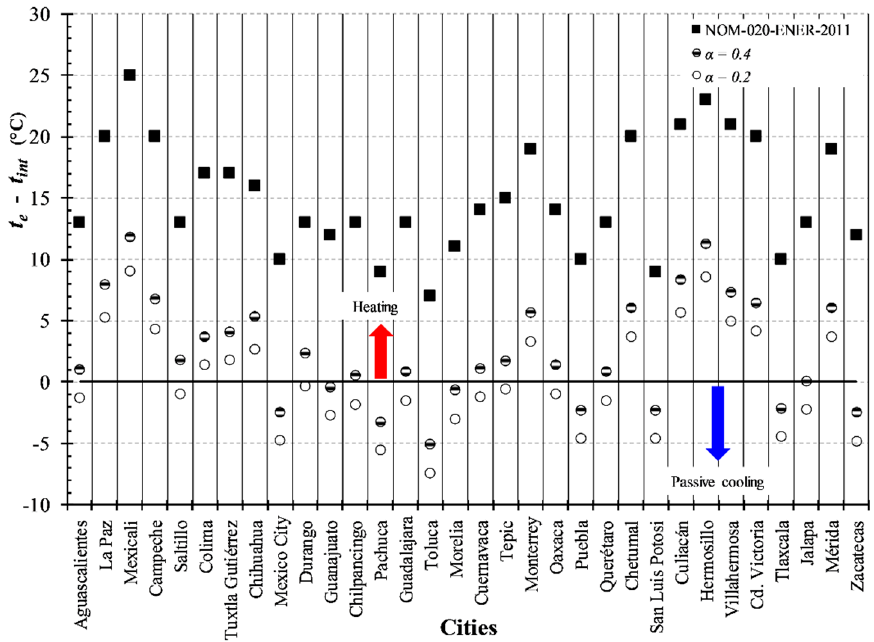
Figure 7. Temperature gradient in roofs at different absorptivity values.